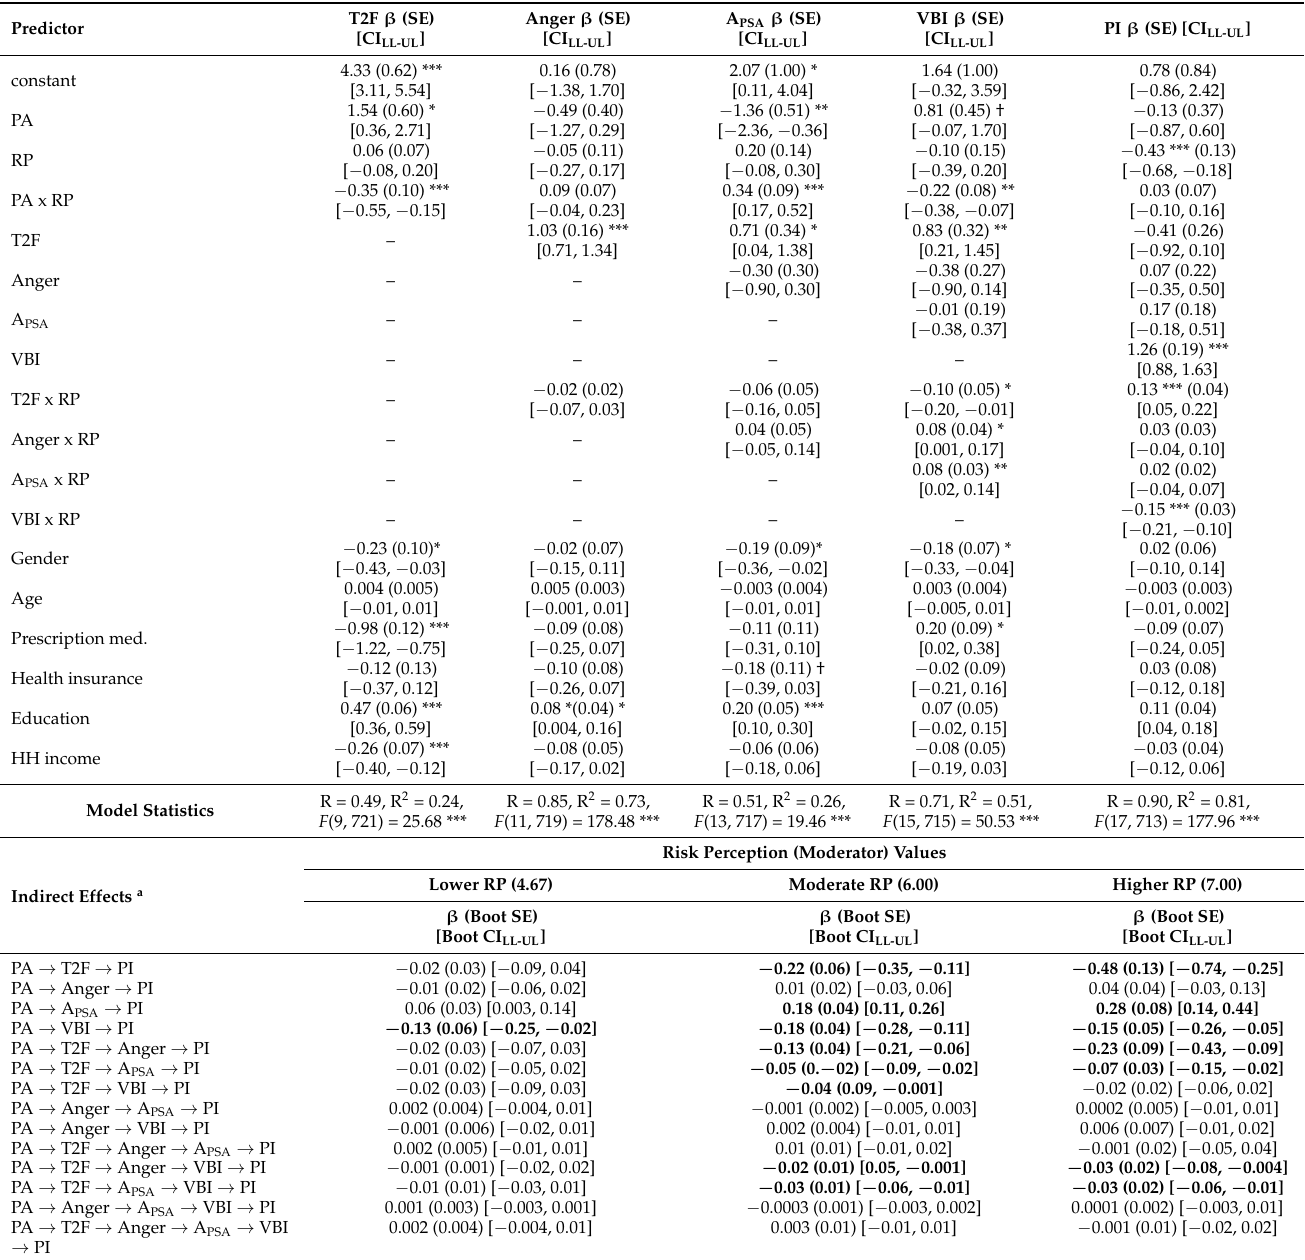
Table 3. Moderated serial mediation results for the effect of persuasive appeal on purchase intention, moderated by risk perception, and mediated serially by T2F, anger, A psa , and